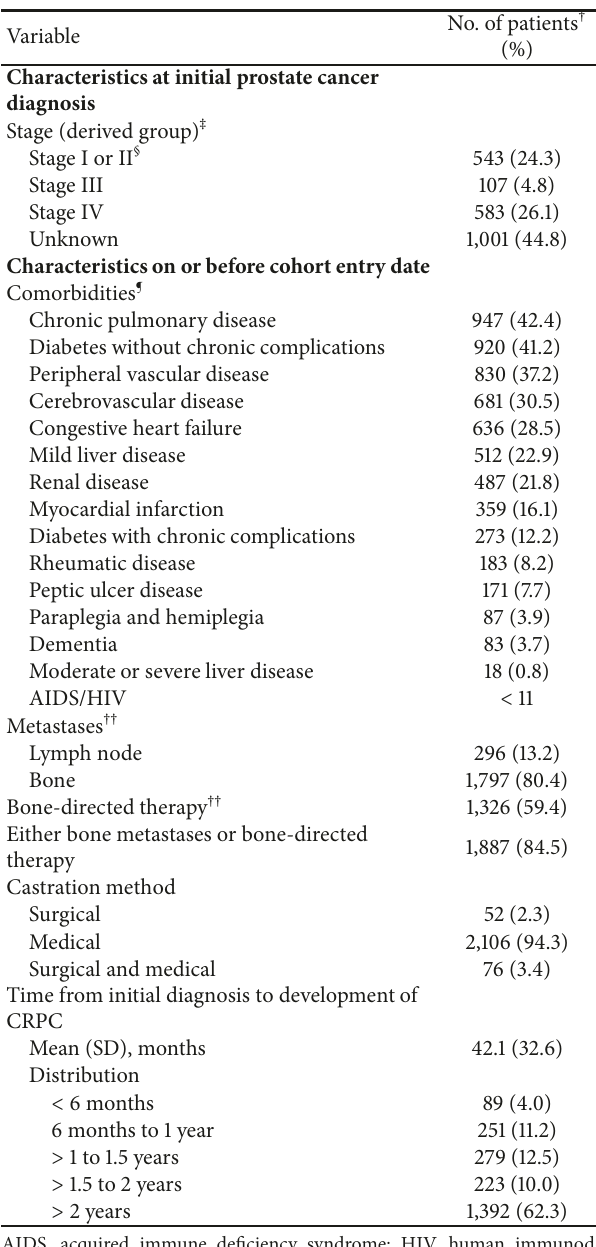
Table 2: Demographic characteristics of study cohort (N = 2,234). Table 3: Clinical characteristics of study cohort (N =